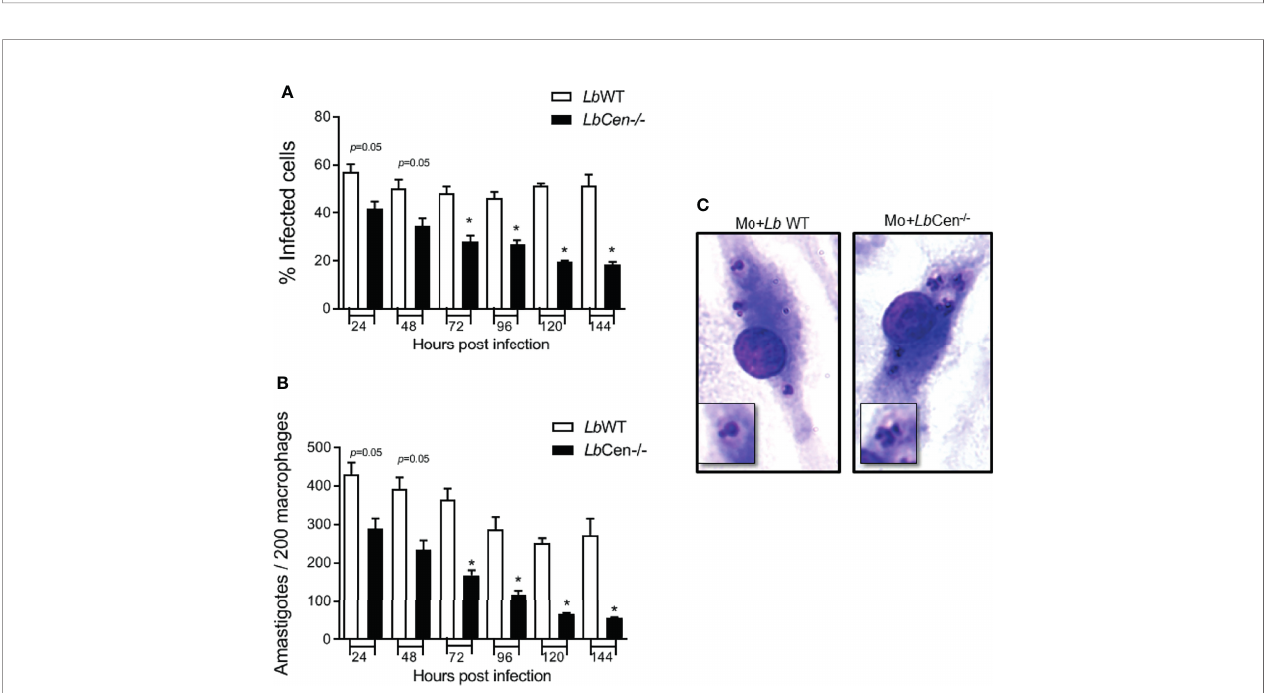
FIGURE 7 | Macrophage infection with LbCen − / − . BMDM were infected with Lb WT or LbCen − / − (10:1, parasite/macrophage ratio) promastigotes for 24 h. Cells were extensively washed and further cultured for 48, 72, 96, 120 or 144 h. Cells were stained with H&E and evaluated for the percentage of infection (A) and the number of amastigotes per 200 macrophages (B) by optical microscopy. (C) Photomicrographs showing infected macrophages at 96 h. Data (mean ± SEM) are pooled from four independent experiments, each performed in quadruplicate. *p < 0.05.